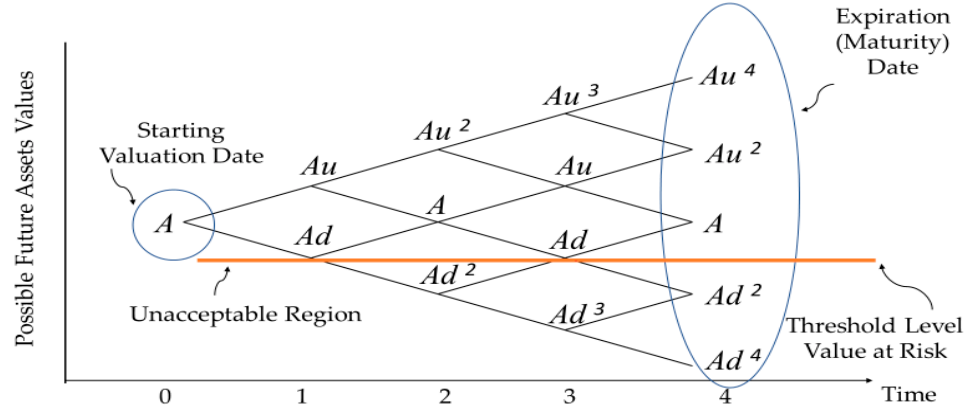
Figure 1. Graphical Representation of the Binomial Option pricing model (the lattice of underlying assets value) and Value at Risk (VaR) model. At node time 1, there are two possible underlying values, Au and Ad; at node time 2, there are three possible underlying values, Au2, A, and Ad2; and so on. Source: Adopted from (Amram and Kulatilaka 1999; Teoh and Sheblè 2007).